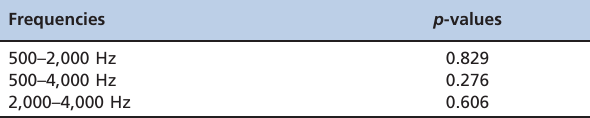
Table 1 - Firefighters responses in relation to the frequencies used (500, 2,200 and 4,000) (Figure 2).